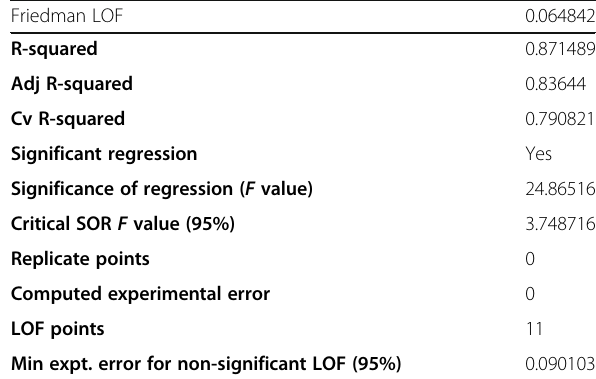
Table 2 Validation parameter of the